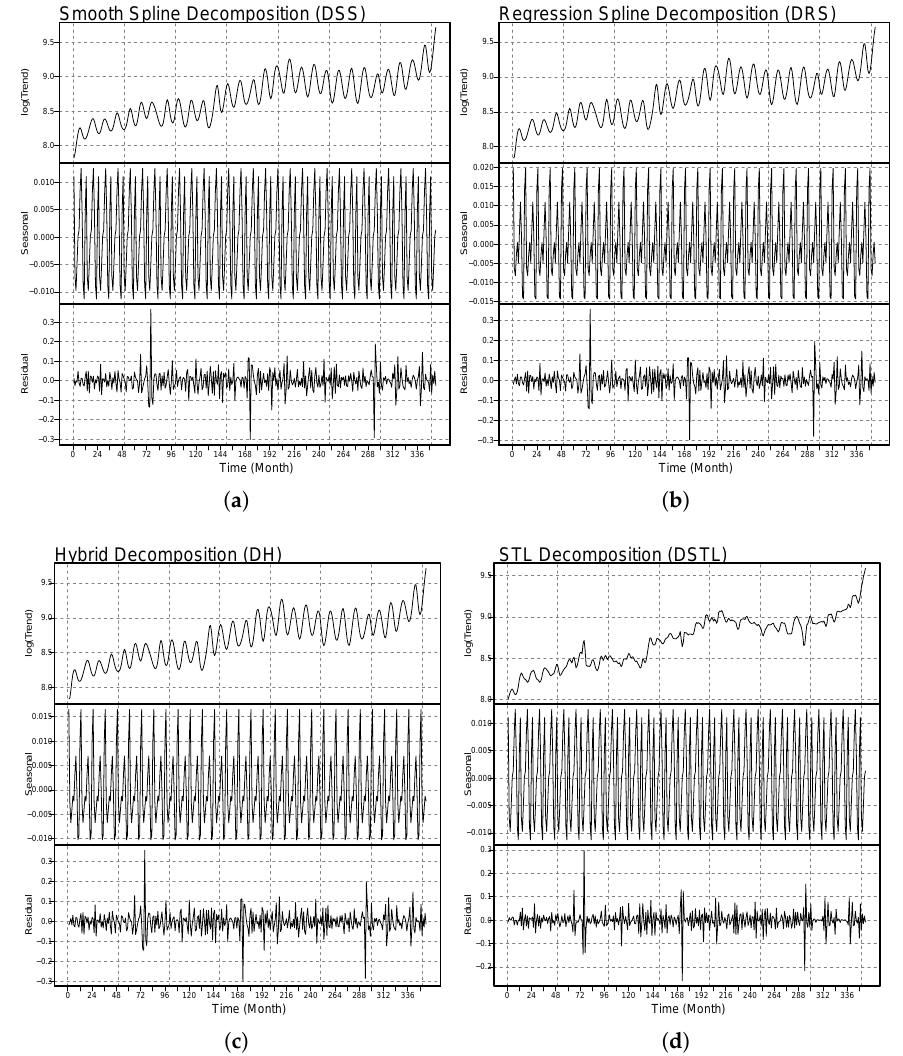
Figure 2. Electricity consumption (kWh) in Pakistan: The monthly electricity consumption series is decomposed by the three proposed decomposition methods: ( a ) DSS, ( b ) DRS, ( c ) DH, and ( d ) the benchmark decomposing method DSTL. In each sub-figure, the top panel shows the long-term trend ( t m ), the middle panel shows the seasonal ( s m ) component, and the bottom panel shows the stochastic component ( r m